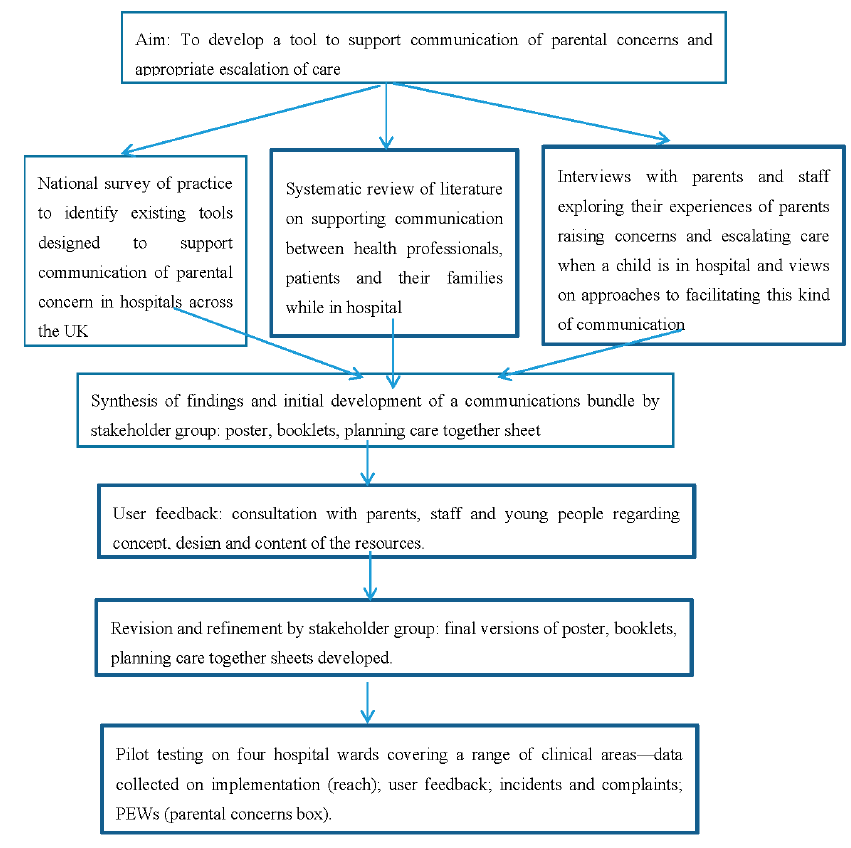
Figure 1. Intervention development and pilot testing.